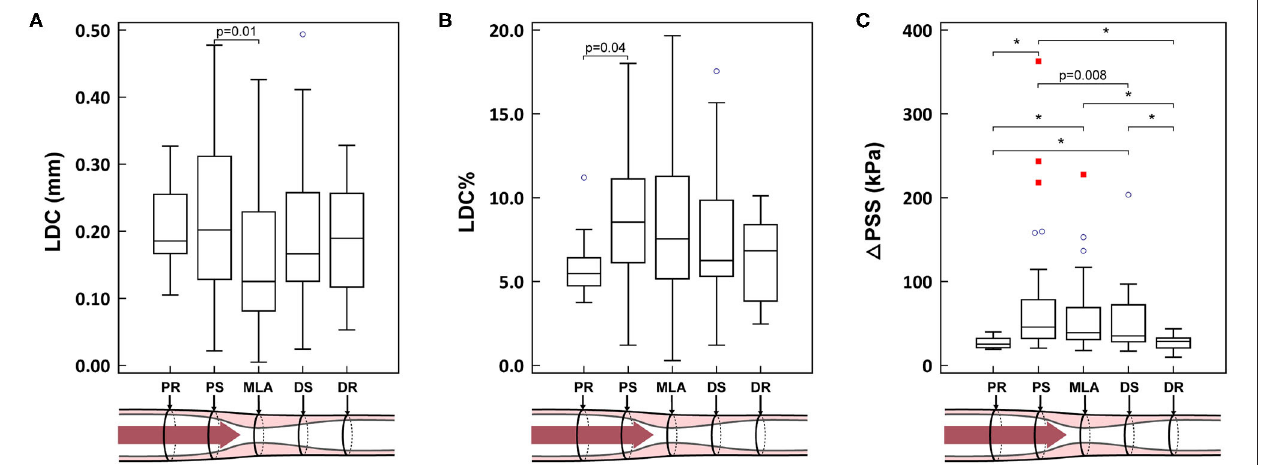
FIGURE 3 | (A–C) Biomechanical results in different locations of the lesion. * p < 0.001. PR, proximal reference; PS, proximal shoulder; MLA, minimal lumen area; DS, distal shoulder; DR, distal reference; LDC, lumen diameter change; LDC%, percent lumen diameter change; 1 PSS, delta plaque structural stress. The blue circles represent the mild outliers, and the red squares represent the extreme